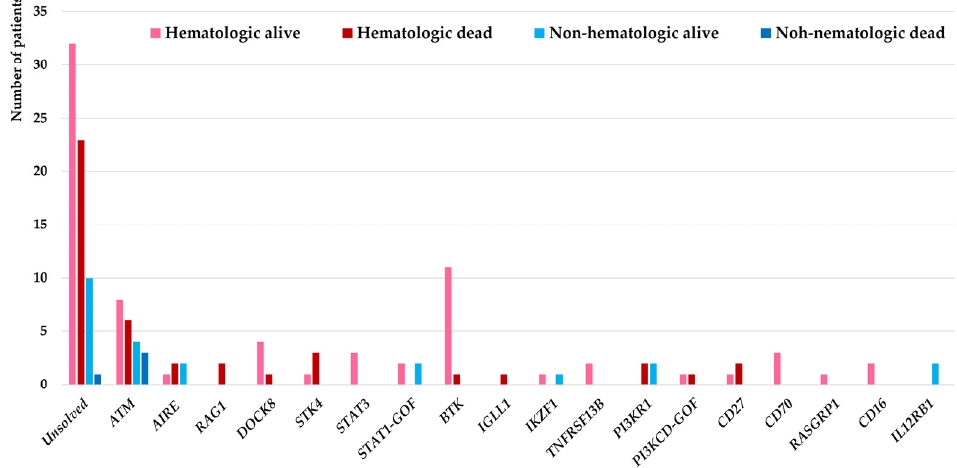
Figure 1. Molecular pathogenesis of 144 IEI patients associated with hematologic and non-hematologic malignancies and their impact on the mortality of patients.